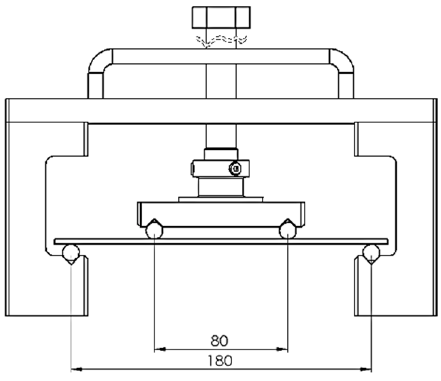
Figure 4. Four-point bending test equipment.